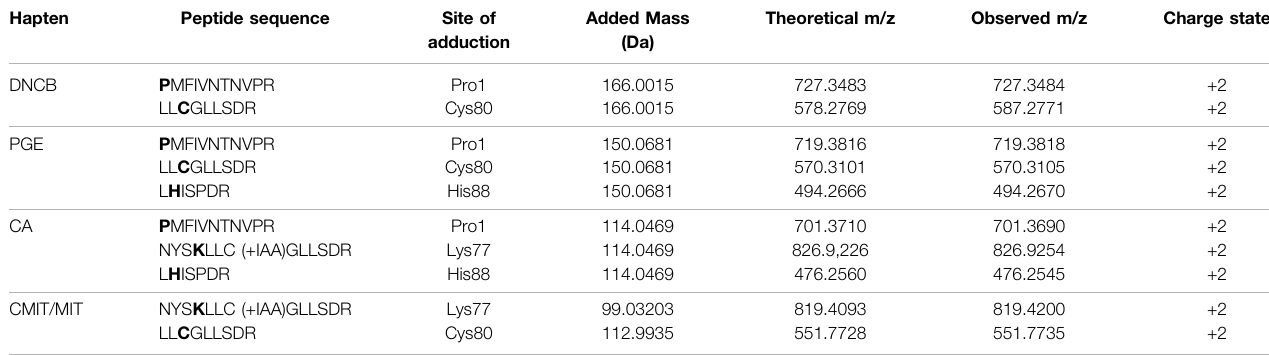
TABLE 4 | Con fi rmed modi fi cations sites after in vitro incubation of MIF with the different haptens. *bold letters indicate the site of adduction. Hapten Peptide